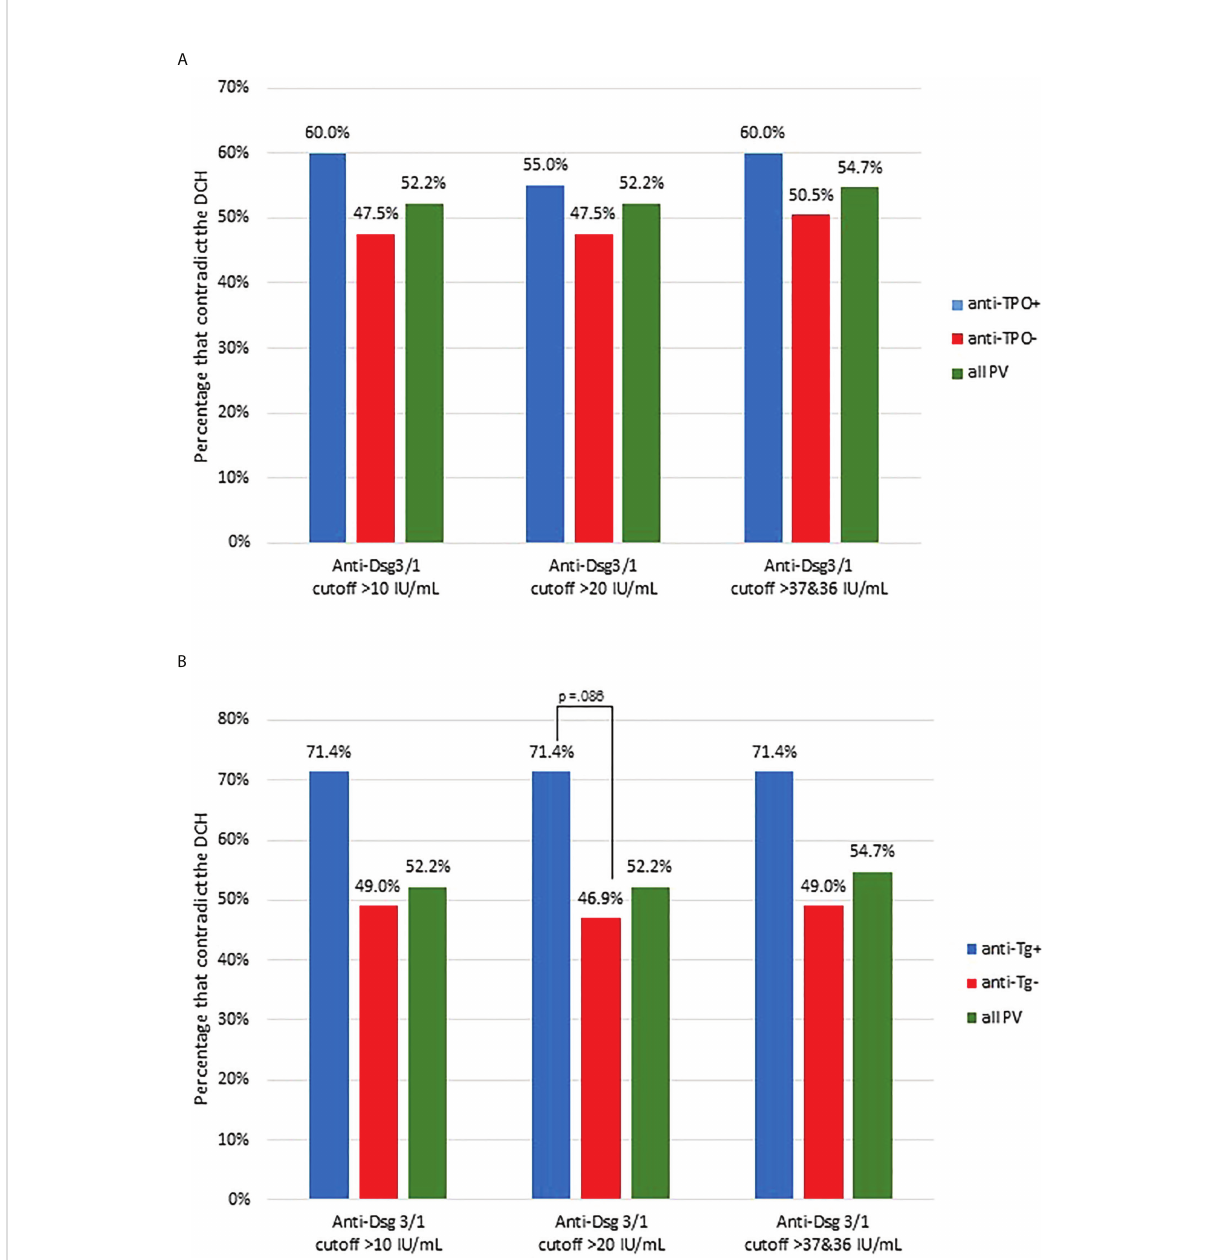
FIGURE 4 Proportion of contradictions to the DCH are slightly increased in PV patients carrying thyroid disease associated antibodies. (A) The proportion of conformity and contradiction to the DCH was assessed in all active PV subjects that had positive anti-TPO antibodies (anti-TPO+, n=20) and compared this proportion to those with negative anti-TPO levels (anti-TPO-, n=101) and all active PV subjects (all PV, n=159). The percentage of contradiction is presented using the 10-, 20-, and 36/36 IU/mL cutoff for anti-Dsg1/3. (B) Anti-Tg+ PV subjects had a higher proportion of contradiction to the DCH than anti-Tg - and all PV subjects. We assessed the proportion of conformity and contradiction in all active PV subjects that had positive anti-Tg positive antibodies (n=14) and compared this proportion to those with negative anti-Tg levels (n=96) and all active PV subjects (n=159). The percentage of contradiction is presented using the 10-, 20-, and 36/36 IU/mL cutoff for anti-Dsg1/3. The difference between anti-Tg+ and anti-Tg- subjects is trending towards signi fi cance